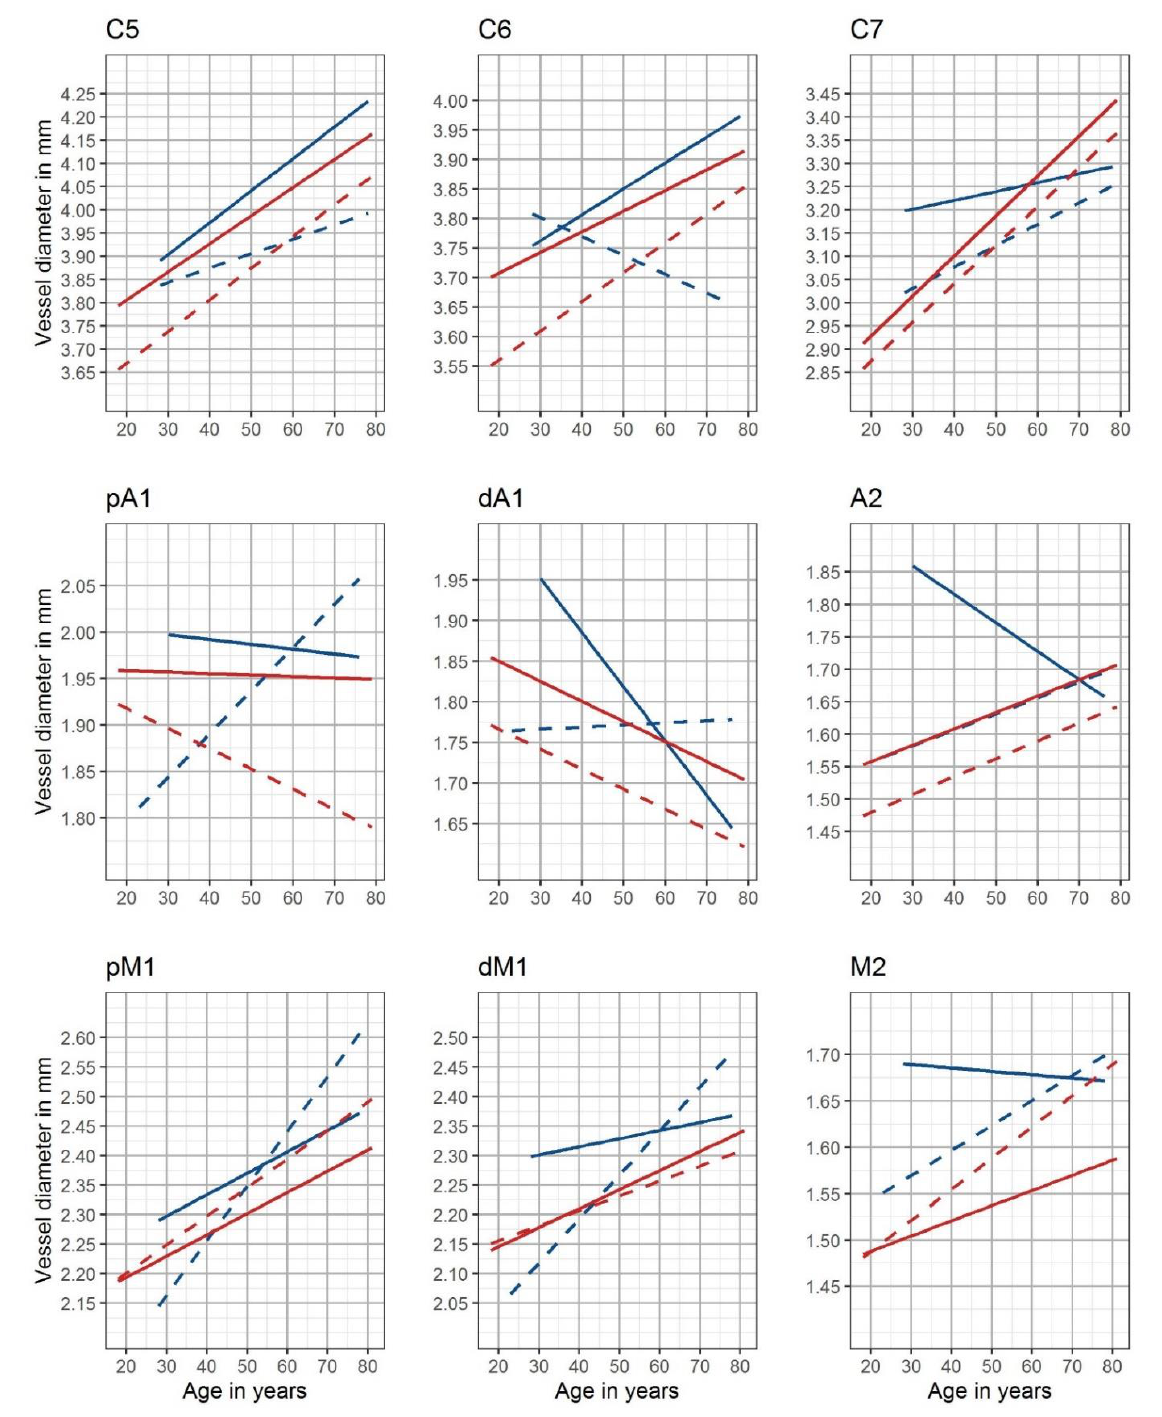
Figure 3. Nomograms of the intracranial arteries. Gender- and side-adjusted nomograms are shown for the nine measuring sites (red: female, blue: male, solid lines: left cranial side, and dotted lines: right cranial side)—C5: clinoid segment of the internal carotid artery; C6: ophthalmic segment of the internal carotid artery; C7: terminal segment of the internal carotid artery; pM1: proximal horizontal segment of the middle cerebral artery; dM1: distal horizontal segment of the middle cerebral artery; M2: insular segment of the middle cerebral artery; pA1: proximal precommunication segment of the anterior cerebral artery; dA1: distal precommunication segment of the anterior cerebral artery; A2: postcommunicating segment of the anterior cerebral